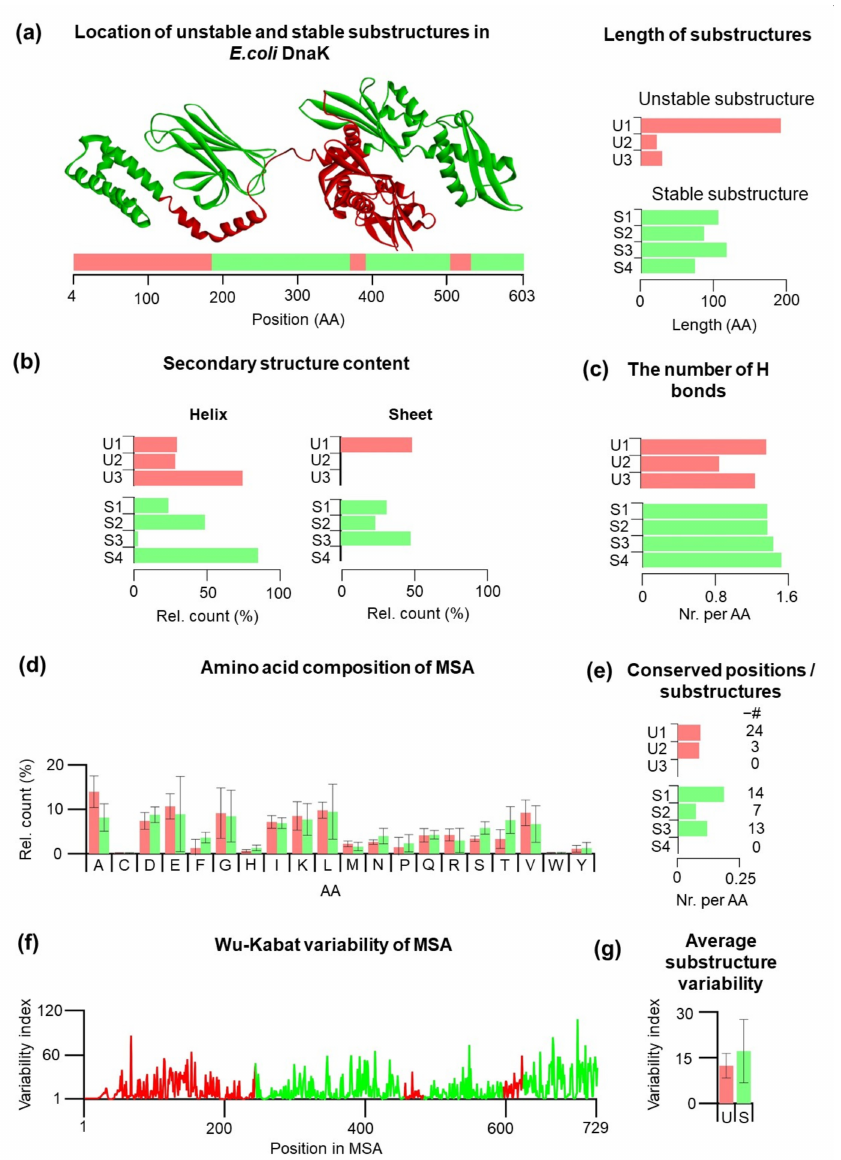
Figure 1. Structural and sequence characterization of Hsp70s and their substructures belonging to U (red) and S (green) classes (see also Supplementary Figure S3). ( a ) The 3D structure and the length of substructures are shown in the closed form (2KHO) of E. coli . The protein consists of three mechanically unstable and four mechanically stable substructures. Substructure S1 is split into two parts by the inserted domain—the substructure S2. ( b ) Secondary structure content of α -helix and β -sheet of S1–S4 and U1–U3 substructures for E. coli DnaK. ( c ) The number of hydrogen bonds per amino acid for U/S substructures. ( d ) Amino acid composition of 205 Hsp70 sequences. The error bars showed variability of the amino acid composition of Hsp70s. ( e ) Conserved positions per amino acid in substructures and absolute numbers of conserved positions for U/S substructures from MSA. ( f ) Wu–Kabat variability of 205 Hsp70 sequences obtained from MSA. ( g ) Averaged variability of residues in U/S substructures obtained from the MSA of 205 Hsp70 sequences. There are no significant differences in variabilities between